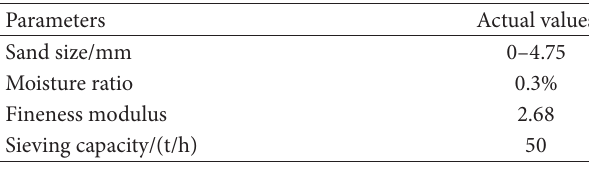
Table 1: Sand properties and operating conditions.